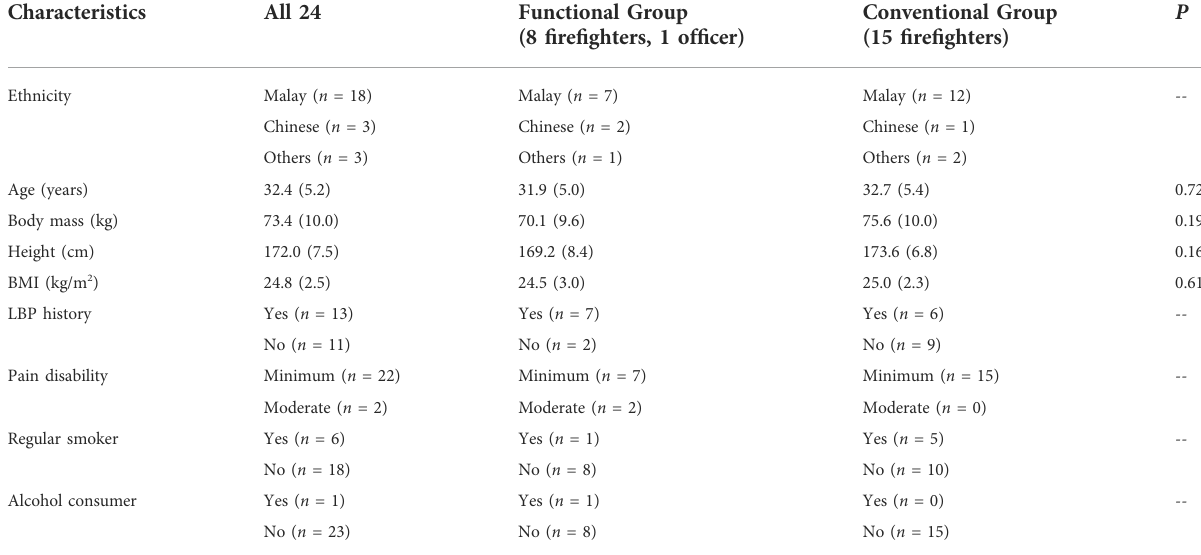
TABLE 1 Physical characteristics and demographic background of emergency responders ( n = 24).